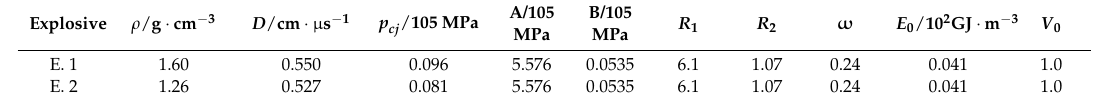
Figure 10. Layout of the drilling boreholes.